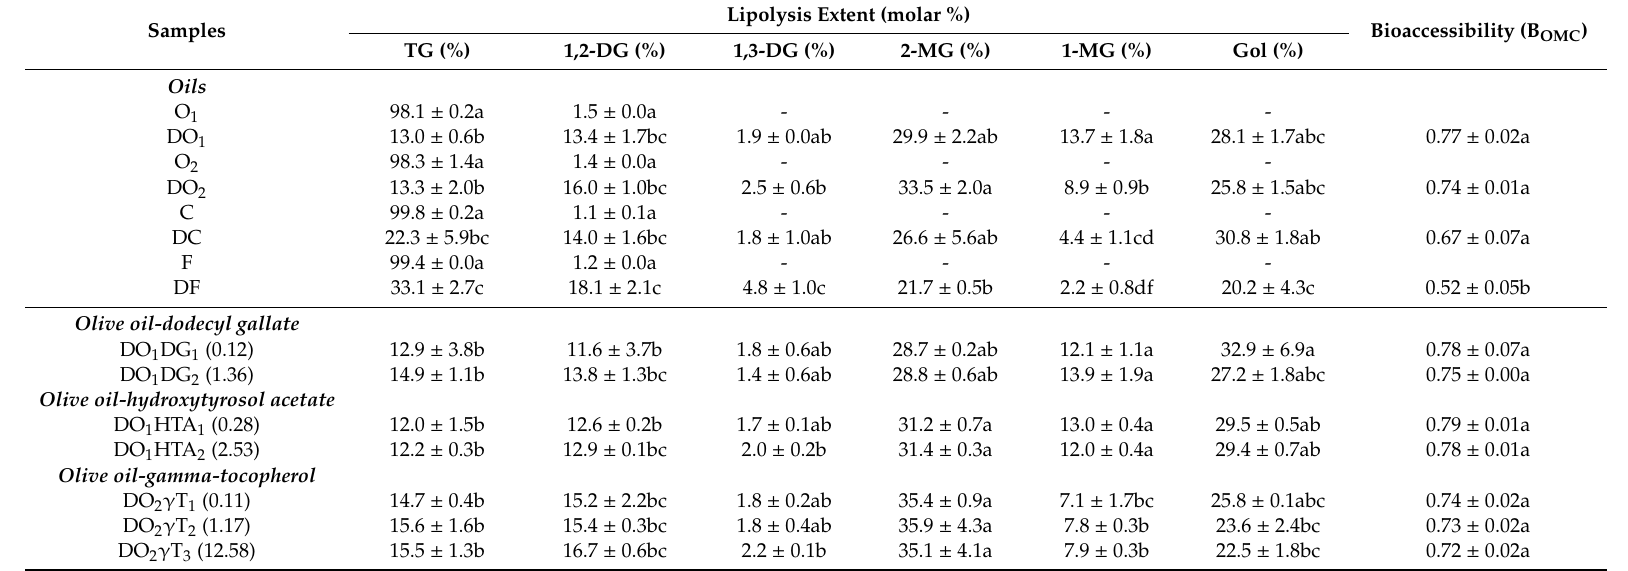
Table 1. Lipolysis extent. Molar percentages of triglycerides (TG), diglycerides (1,2-DG and 1,3-DG), monoglycerides (1-MG and 2-MG) and glycerol (Gol) in relation to the total glyceride structures, in olive oils (O 1 and O 2 ), in corn oil (C) and in virgin flaxseed oil (F), in the digestates of these oils (DO 1 , DO 2 „ DC and DF) and in those of the samples enriched with dodecyl gallate, hydroxytyrosol acetate and gamma -tocopherol (DO 1 DG 1 , DO 1 DG 2 , DO 1 HTA 1 , DO 1 HTA 2 , DO 2 γ T 1 , DO 2 γ T 2 ,and DO 2 γ T 3 ) whose level of enrichment in phenolic compounds is given in brackets in mmol / mol (AG + FA) O . Bioaccessibility of oil main components after in vitro digestion (B OMC ), defined by the ratio (mol [FA] + [MG]) D / mol ([FA] + [AG]) D ), where FA means fatty acid and AG acyl groups. Di ff erent letters within each column indicate statistically significant di ff erences among the samples ( p < 0.05). Data of corn and virgin flaxseed oils and of their digestates were taken from previous studies